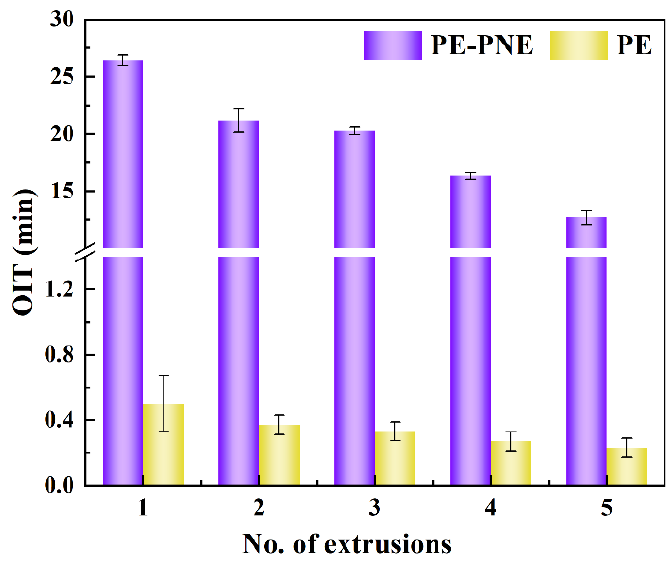
Figure 2. OIT values of PE and PE-PNE samples vs. the number of extrusions.